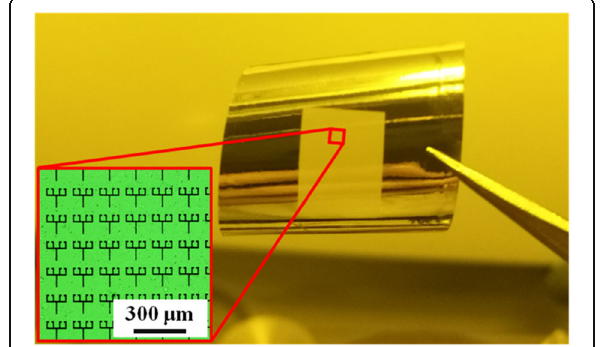
Fig. 2 Fabricated sample of the conductively coupled terahertz EIT metamaterial. The microscopic image of the fabricated conductively coupled structure is shown in the